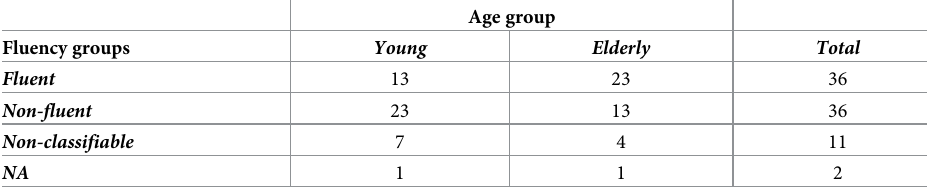
Table 2. Fluency groups determined according to Luria’s classification of aphasia in the main PWA group. Age group Fluency groups Young Elderly Total Fluent 13 23 36 Non-fluent 23 13 36 Non-classifiable 7 4 11 NA 1 1